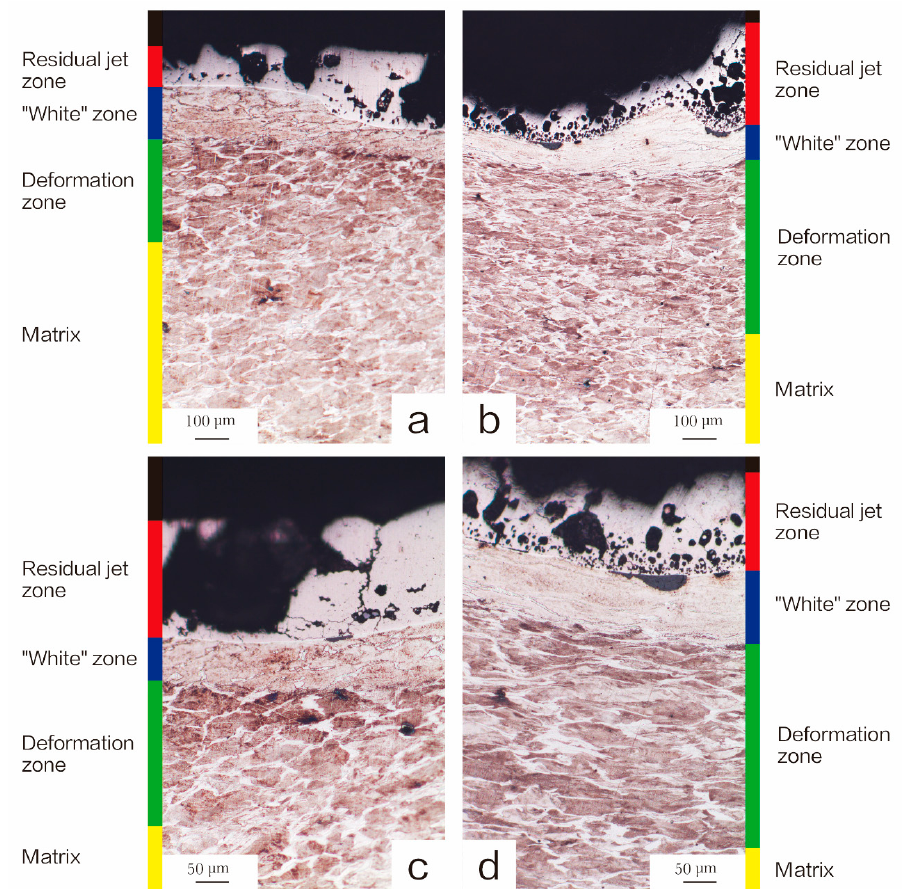
Figure 8. The microstructure of the crater walls penetrated by Cu-Ni-Al reactive-shaped charge liner. ( a ) the head of the crater walls (100×); ( b ) the tail of the crater walls (100×); ( c ) the head of the crater walls (200×); ( d ) the tail of the crater walls (200×).